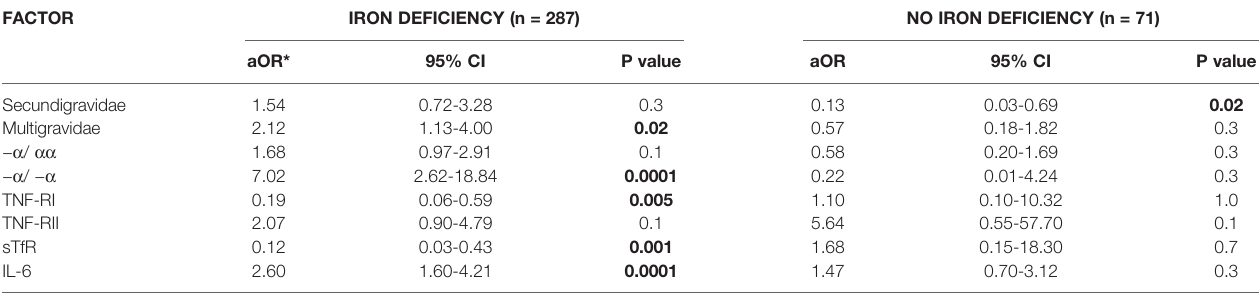
TABLE 4 | Multivariate logistic regression analysis of risk factors for fetal anemia in offspring of mothers with OR without iron de fi ciency. FACTOR IRON DEFICIENCY (n = 287)